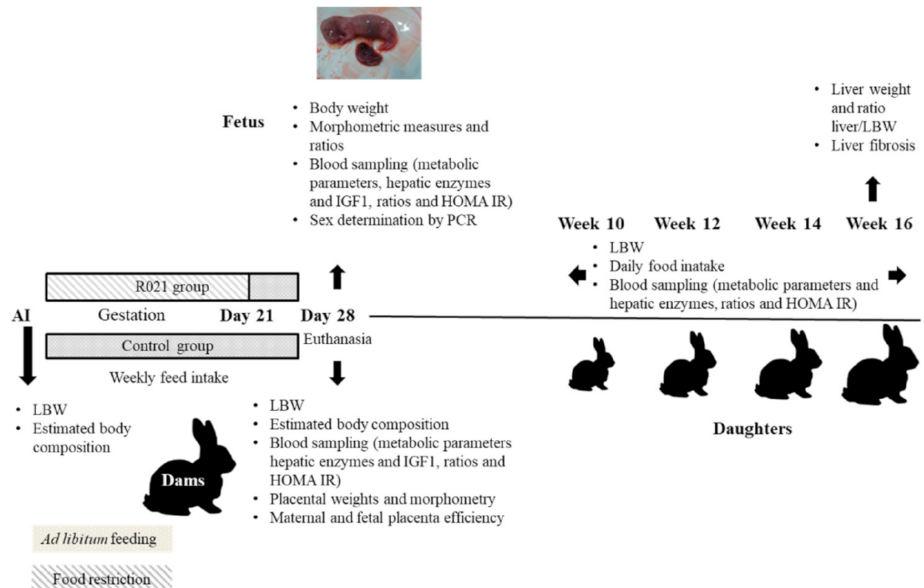
Figure 1. Experimental design. Mothers of R021 group were food restricted from Day 0 (artificial insemination, AI Day) to Day 21 (105 g/day) that means the first two-thirds of gestation, and ad libitum fed during the last third of gestation (gestation length is 31 days). Control group was fed ad libitum all the gestation period. Sampling time for dams was Day 0 and Day 28 (pre-term). For offspring, sampling time was on Day 28 of gestation (fetuses) and, from week 10 to 16 (juvenile phase), when assessments were taken each two weeks. LBW: live body weight; IGF1: insulin growth factor 1; HOMA-IR: homeostatic model